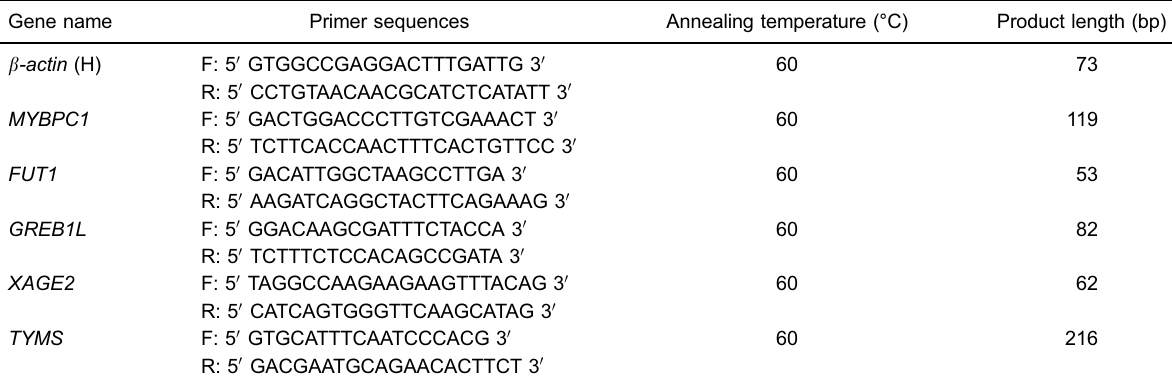
Table 1. Upstream and downstream primer sequences.